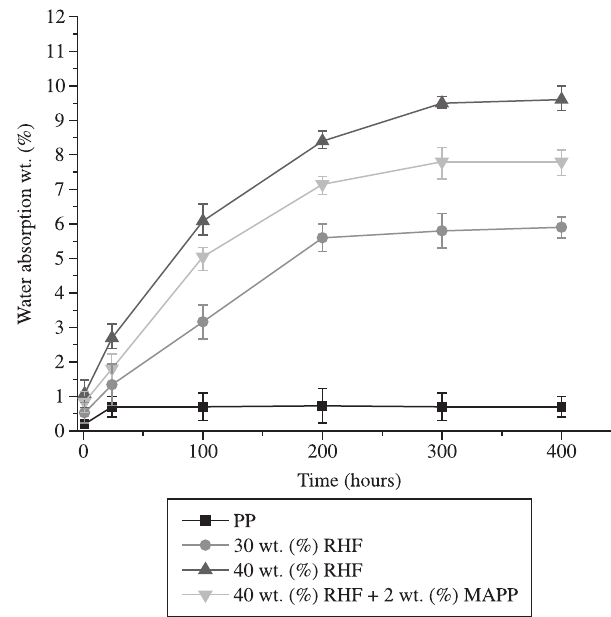
Figure 5. Water absorption in the presence of MAPP.